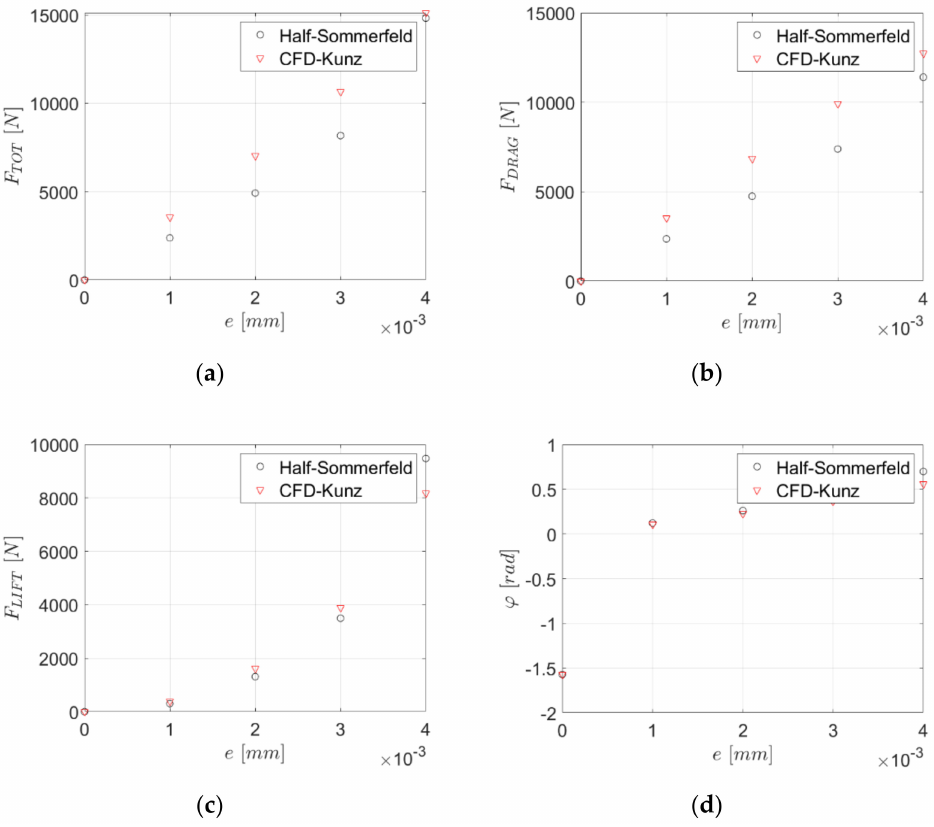
Figure 7. Total hydraulic force ( a ); Drag (F ⊥ ) force ( b ); Lift (F || ) force ( c ) and attitude angle ( d ) vs. eccentricity; 3000 rad /